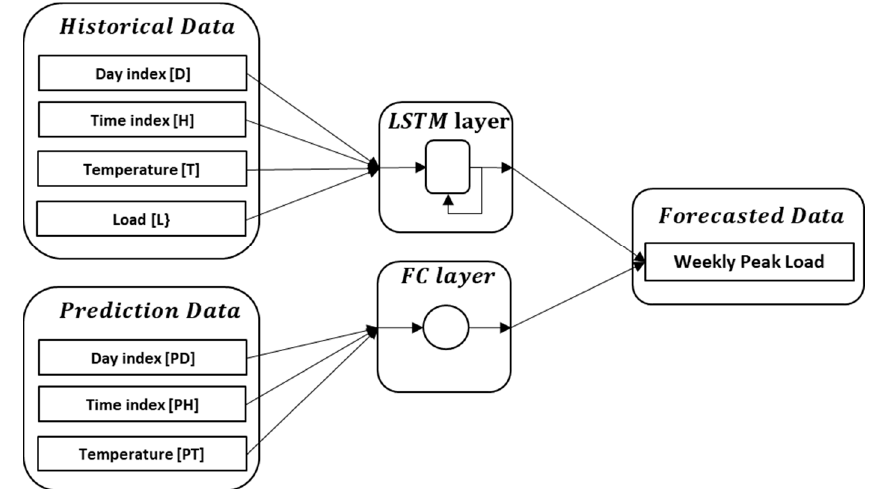
Figure 4. Structure of the short-term load forecasting (STLF) model based on long short-term memory (LSTM).